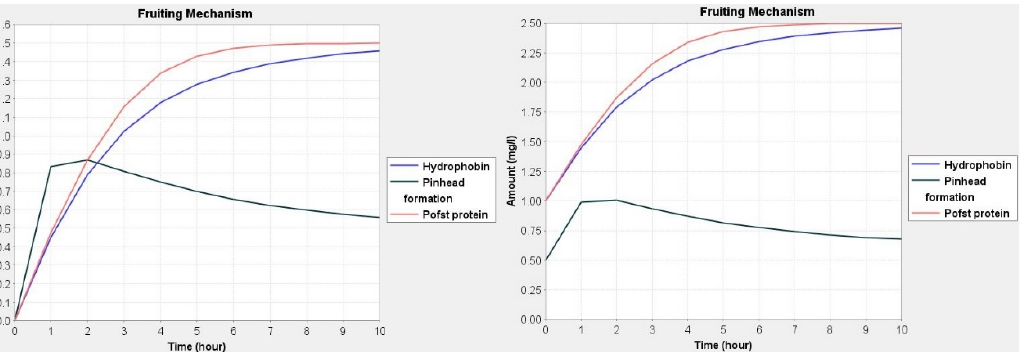
Figure 4. Dynamics of hydrophobin protein and Pofst protein with respect to pinhead formation, the amount of hydrophobin and pinhead formation were set at 0.0 and 1.0, respectively, while Pofst protein was set at 0.0 and 0.5.